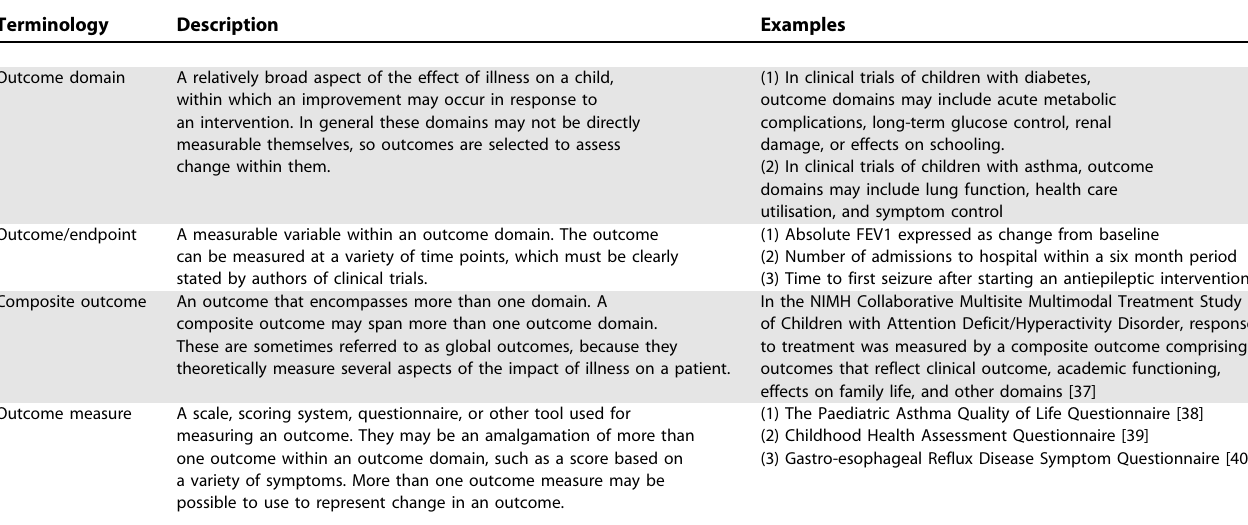
Table 1. Definitions Used in